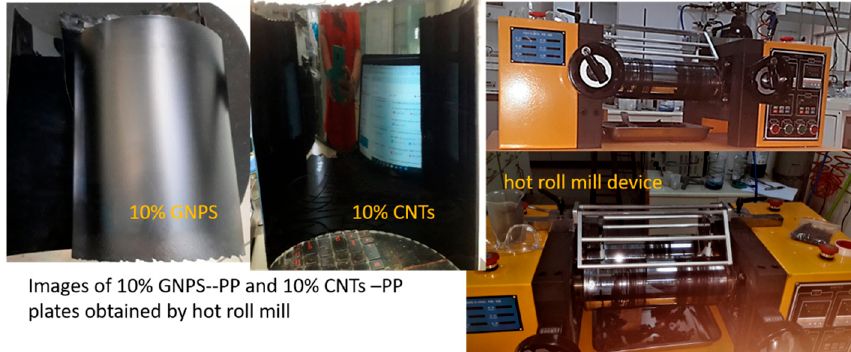
Figure 1. Examples of composite materials panels and photos of the hot roll mill device.